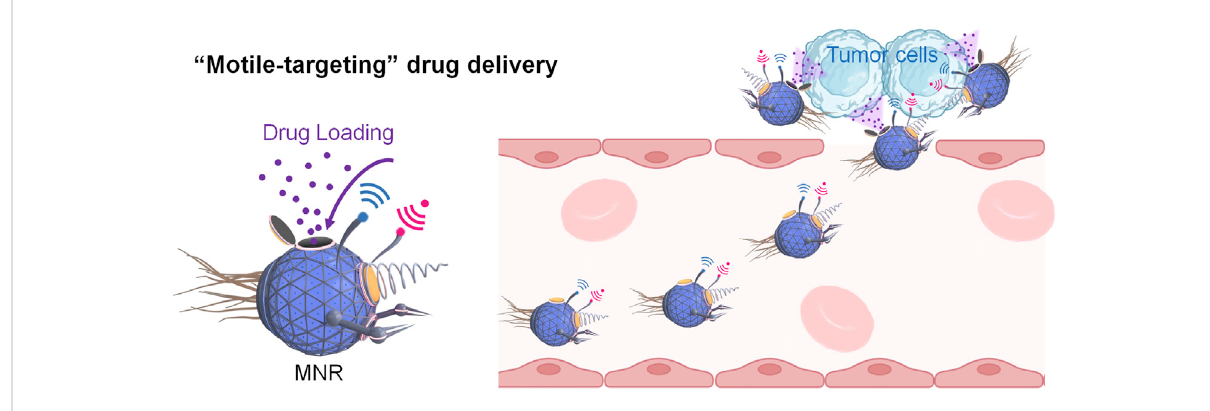
FIGURE 1 Schematic illustration of “ motile-targeting ” drug delivery of micro/nanorobots